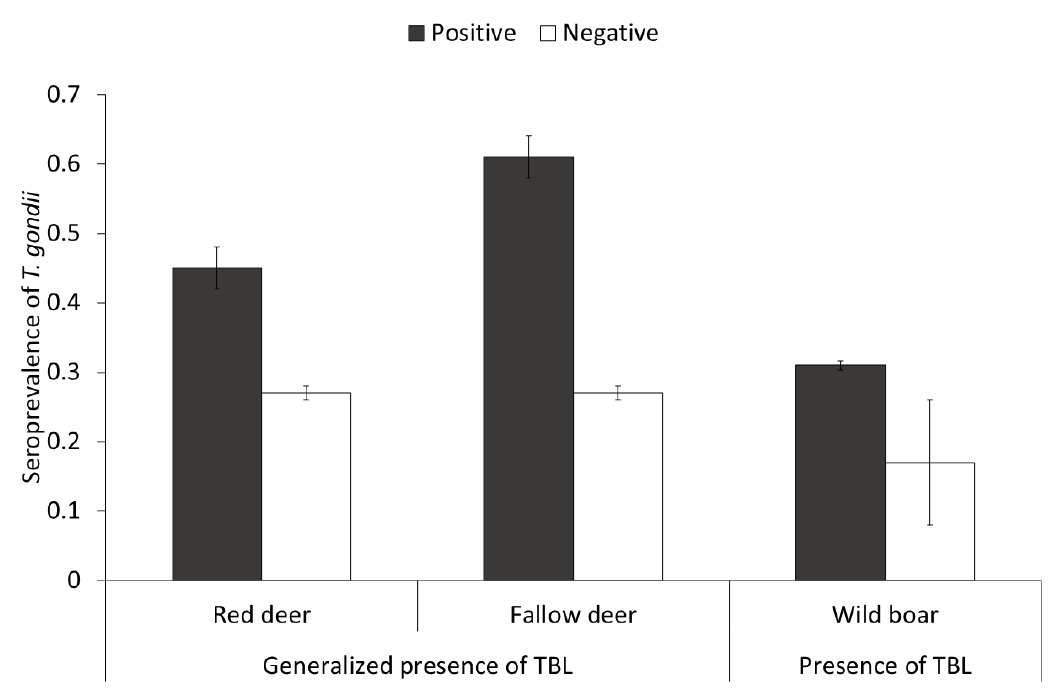
Figure 4. Seroprevalence (± CI 95%) of Toxoplasma gondii depending on the tuberculosis status in